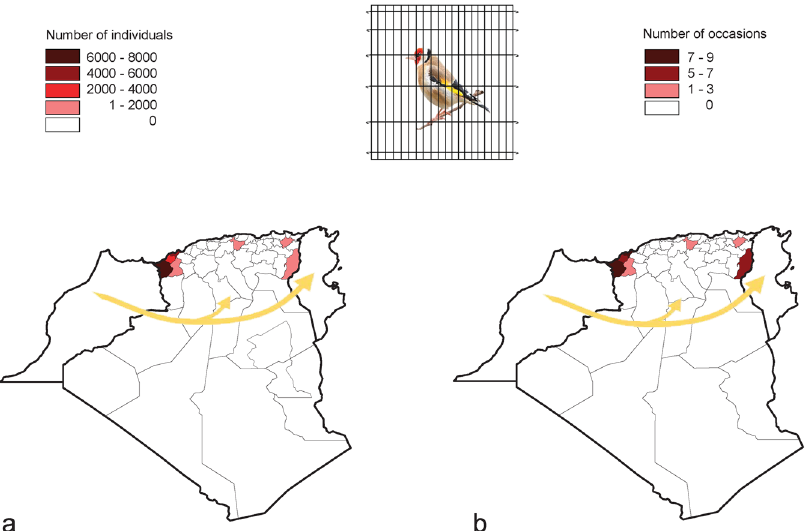
Figure 6. Number of individuals ( a ) and occasions ( b ) of interceptions of the European goldfinch ( Carduelis carduelis ) by authorities in Algeria. The yellow arrow indicates the direction of European goldfinch exportation for international trading. Algeria is divided into administrative provinces. The map was made with MapInfo Professional software (version 15.0, http://www.pitneybowes.com/us/location-intelligence/geographic- information-systems/mapinfo-pro.html).